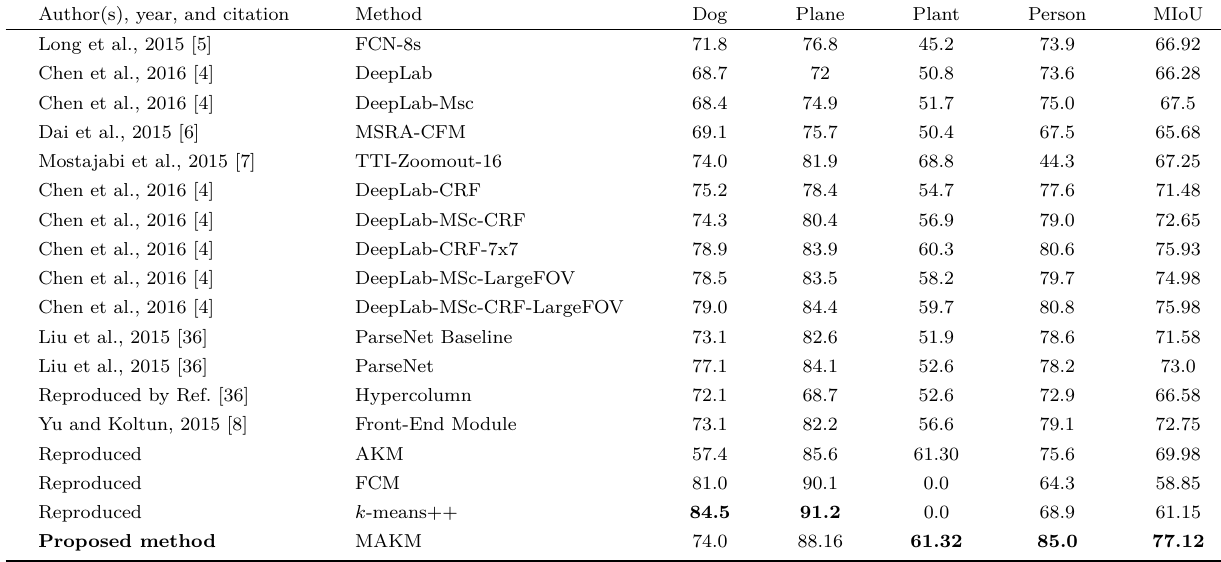
Table 11 Related works from learning-based methods and clustering algorithms for comparison with proposed method in terms of IoU and MIoU for selected images from VOC2012 dataset Author(s), year, and